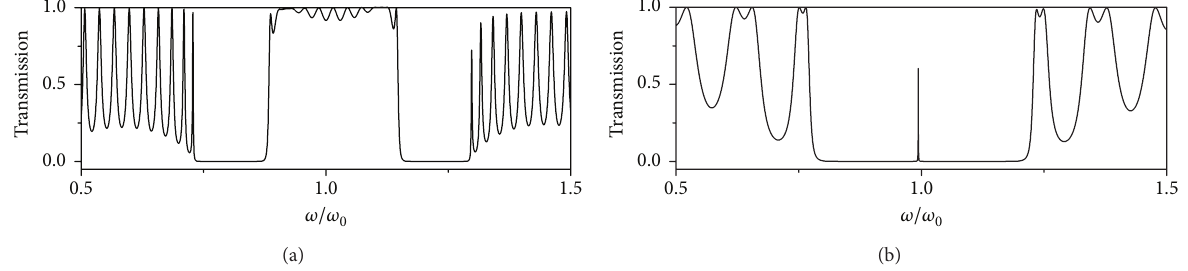
Figure 4: The quantum transmissivity of 1D PCs with 𝑛 𝑏 = 2 . 45 + 𝑖 0 . 0001. (a) The structure is (𝐵𝐵𝐴𝐵𝐵) 12 ; (b) the structure is (𝐵𝐴) 6 (𝐴𝐵) 6 .